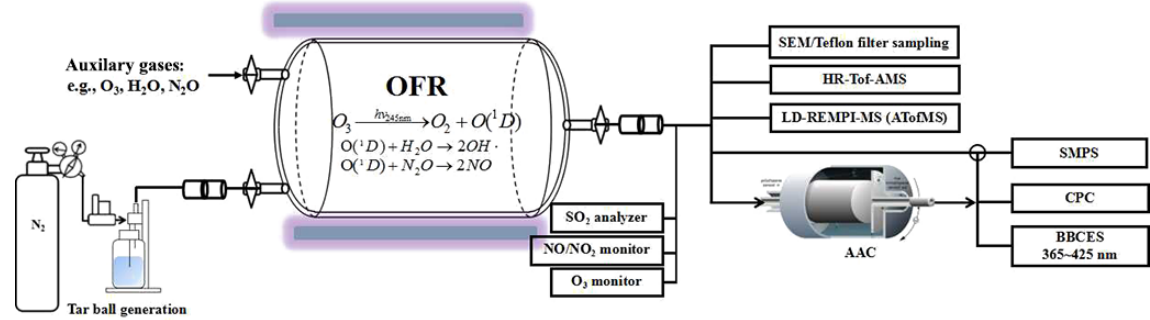
Figure 1. Experimental setup for laboratory generation and aging of tar ball aerosol, including generation setup, OFR photochemical aging, gaseous–particulate chemical monitoring, particle size distribution and optical property